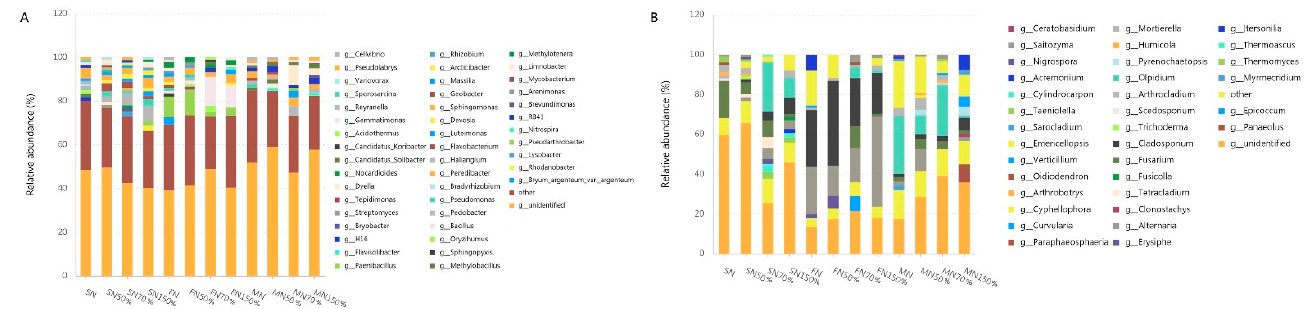
Figure 4. Microflora structure fromall samples at the genus level. ( A ) Bacteria; ( B ) Fungi.